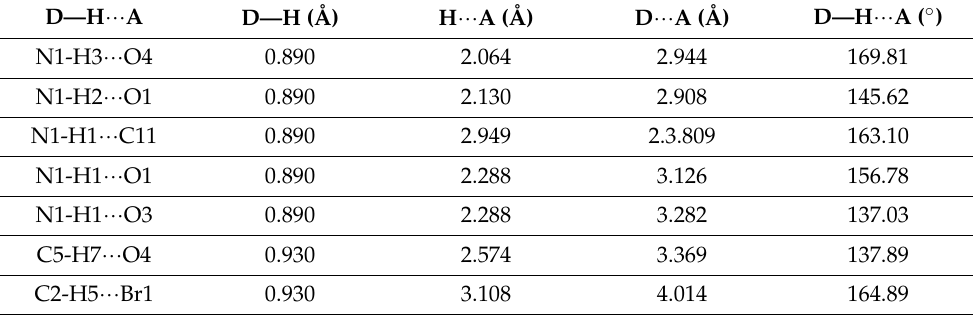
Figure 3. Crystal packing diagram with hydrogen bond network along the b-axis (the hydrogen bonds are shown in cyan lines). Table 2. Geometrical structural parameters of optimized geometry and single-crystal structure. Table 3. Hydrogen bond geometry of